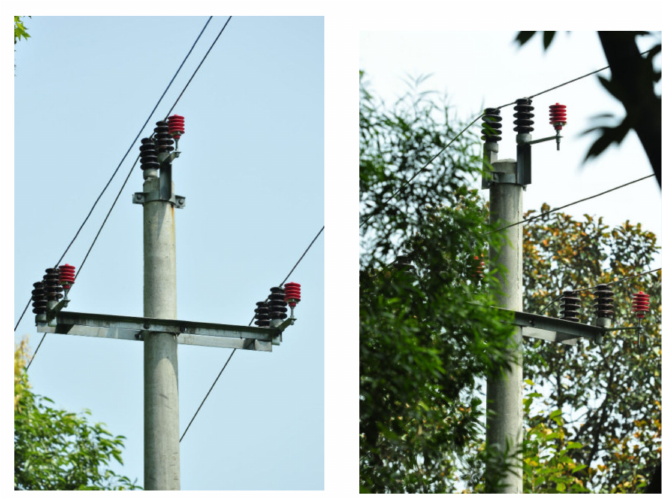
Figure 15. Pictures of application of the